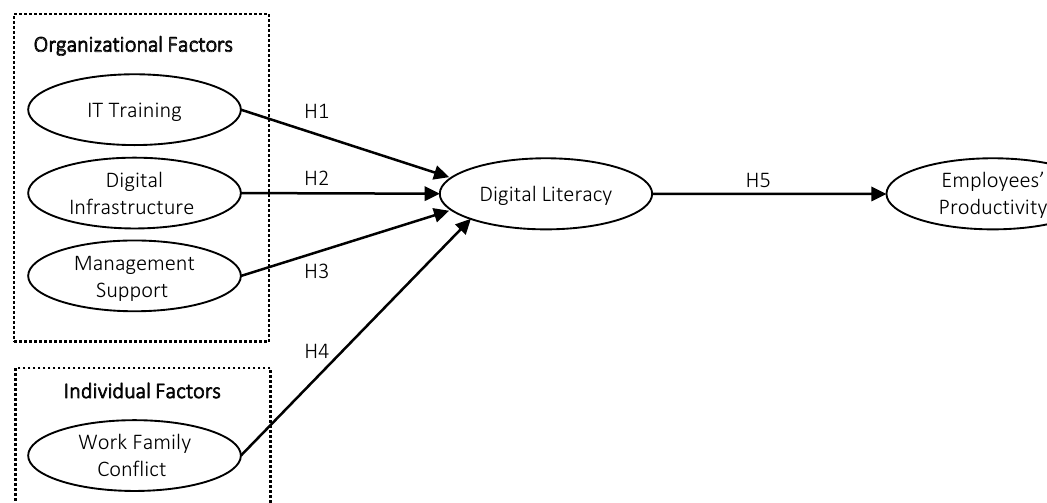
Figure 3. Conceptual Framework of